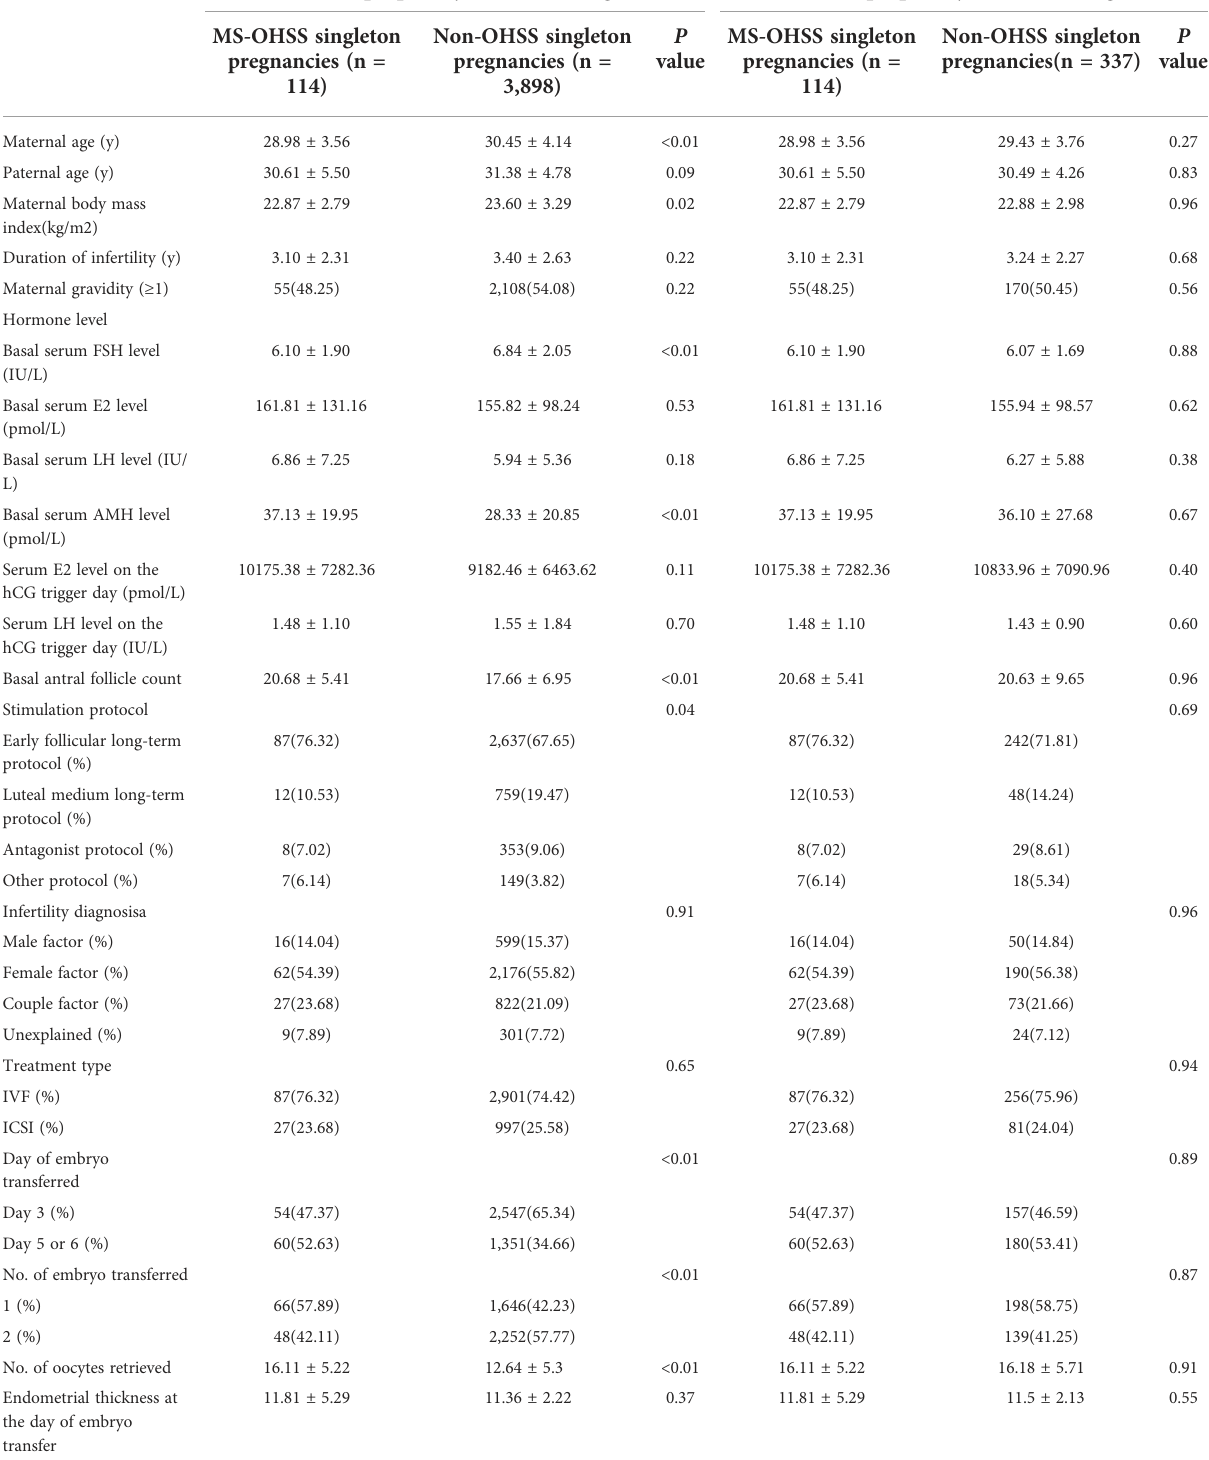
Data are presented as mean ± standard deviation or n (%). The variables in the propensity score matching included maternal age, maternal body mass index, basal serum FSH level, basal serumAMHlevel,typeofstimulationprotocol,basalantralfolliclecount,numberofoocytesretrieved,dayofembryodevelopmentforembryotransfer,numberofembryotransferred.MS- OHSS, moderate-to-severe ovarian hyperstimulation syndrome; FSH, follicle-stimulating hormone; LH, luteinizing hormone; E2, estradiol; AMH, anti-Müllerian hormone; hCG, human chorionic gonadotropin; IVF, In vitro fertilization; ICSI, intracytoplasmic sperm